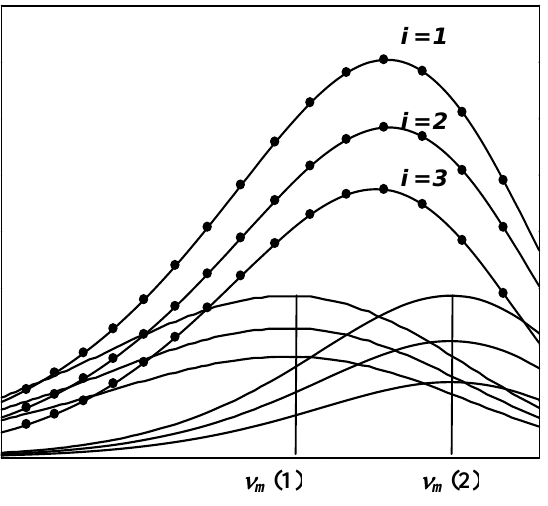
Figure 4. Plot of three fluorescence spectra measured at three different concentration of quencher ( i = 1, 2 and 3) (black points). Each spectrum was decomposed into two components with position of maximum of spectral components at  shape of the first and second spectral components is described by normalized log-normal functions  (1, j) and  (2, j) , with intensities I(1, i) and I(2, i) ,